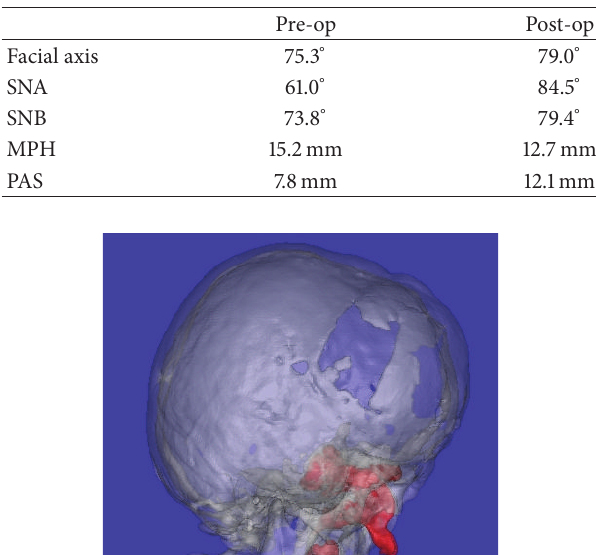
Table 2: Lateral cephalogram before and after surgery.